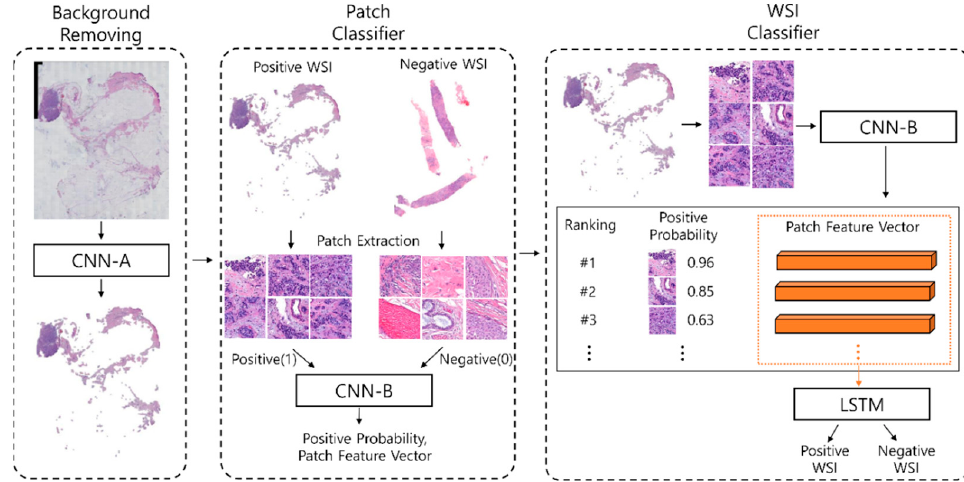
Figure 7. Overall architecture of the model developed by team Arontier_HYY.